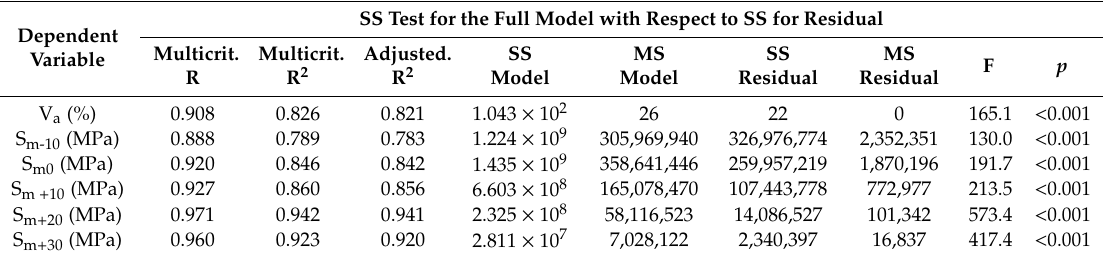
Table 8. Parameters of the models characterizing the variables subjected to optimization. Dependent